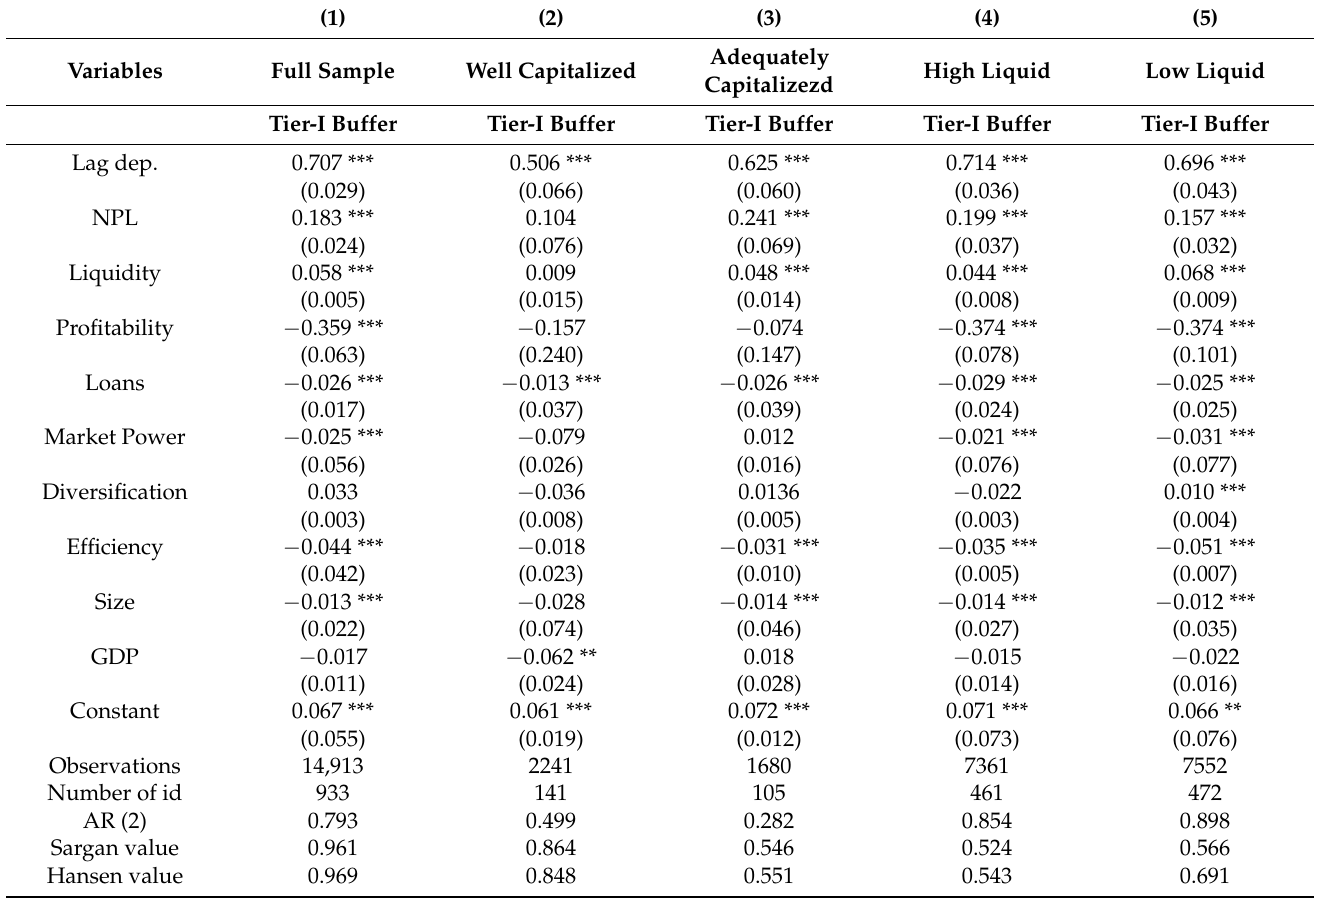
Table 6 used a two-step GMM method to measure the impact of macroeconomic fluctuation on banks’ capital buffer (ratio of tier-1 to risk-weighted assets minus 6%) adjustment for the full sample, well, adequately, and high- and low-liquid banks. If the overall risk-based capital ratio (tier I + II/total risk-weighted assets ratio) of banks is 10% or above it is well-capitalized, if the ratio is between 8 to 10% it is considered an adequately capitalized bank. Based on their median value, commercial banks are classified as highly liquid or low-liquid banks. Banks with a higher ratio of liquid assets to deposits and short-term funding than the median are treated as highly liquid banks and low-liquid banks otherwise. Robust standard errors are reported in parentheses. *** and ** represent statistical significance at 1, and 5%,